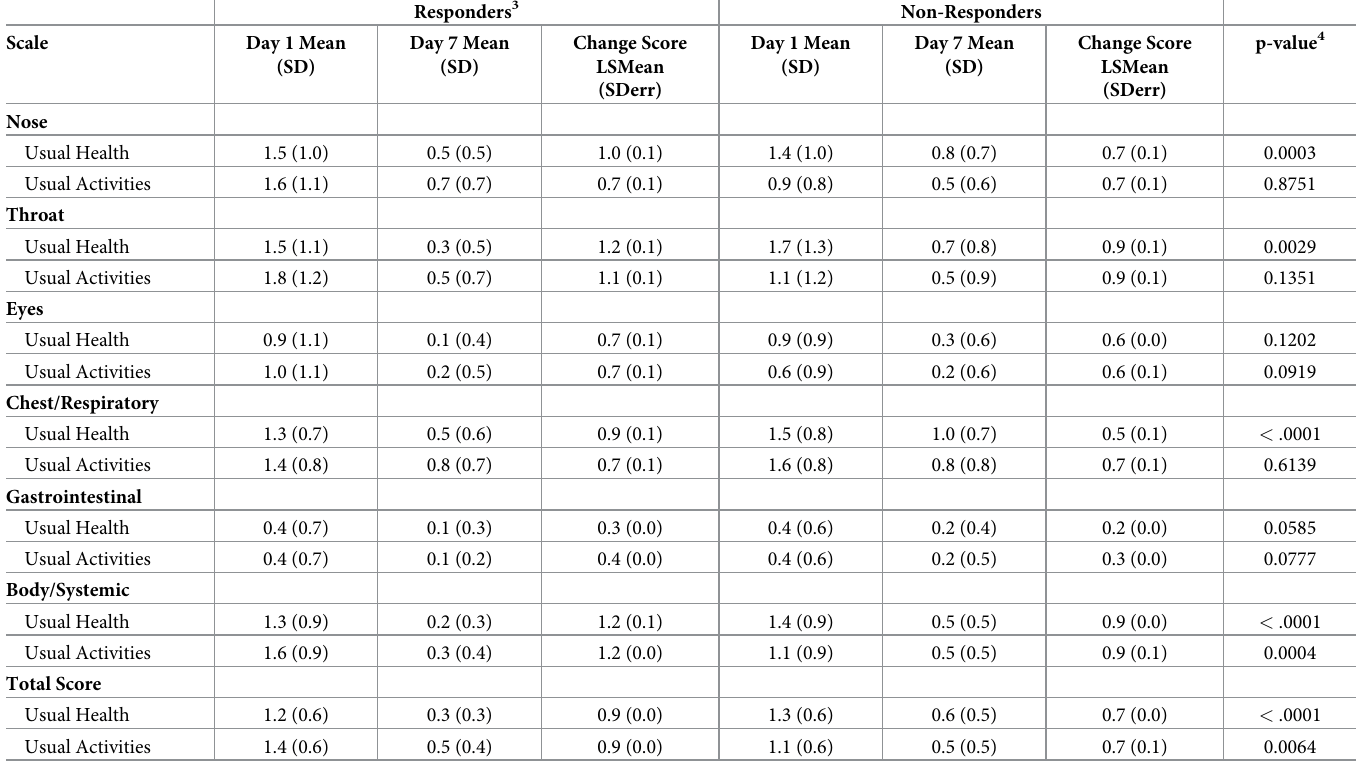
Table 6. Responsiveness of FLU-PRO by patient return to usual health (N = 169) 1 and usual activities (N = 117) 2 , Day 1 to Day